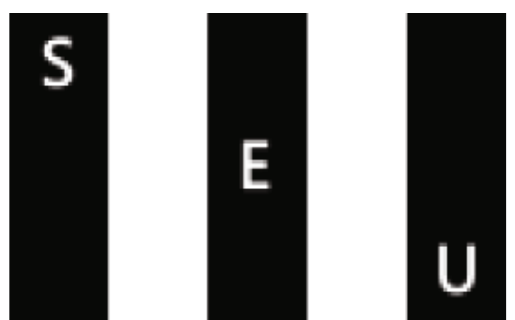
Figure 6: The reconstruction distribution of the point light source array.